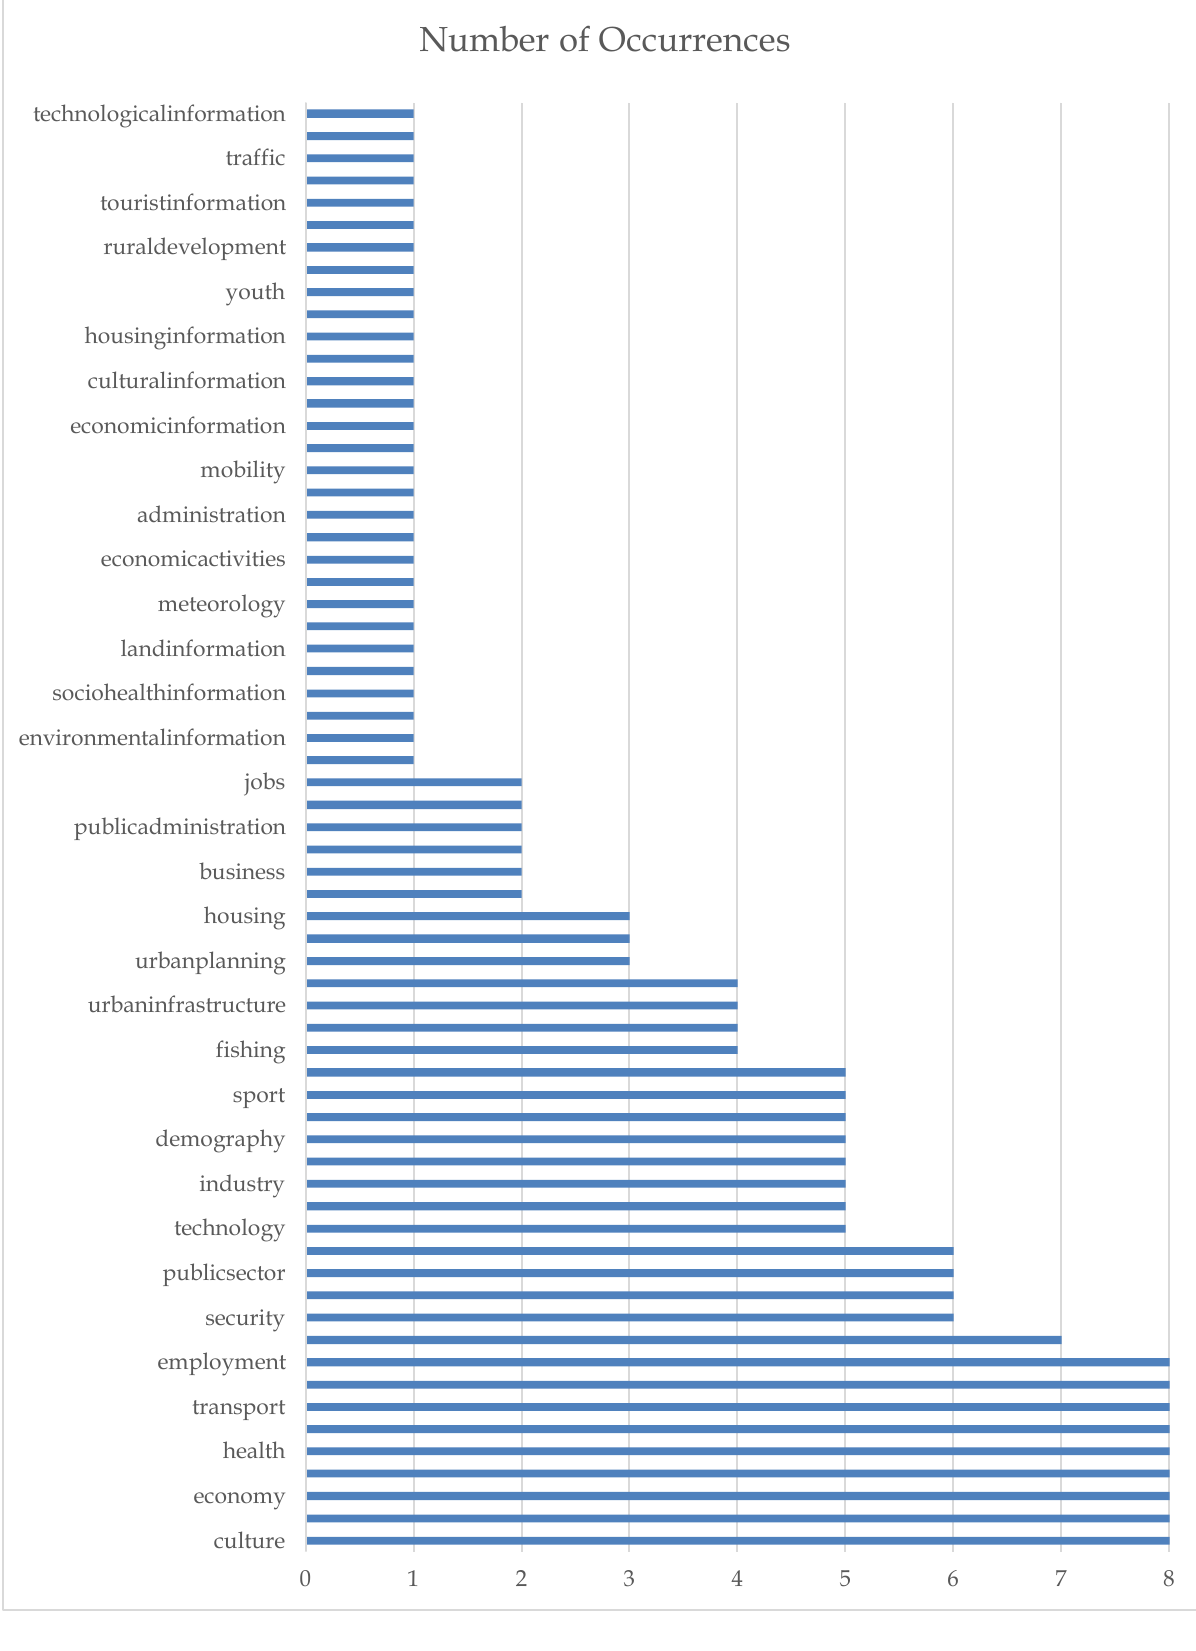
Figure 2: Categories of Spanish Open Data Catalogs and their